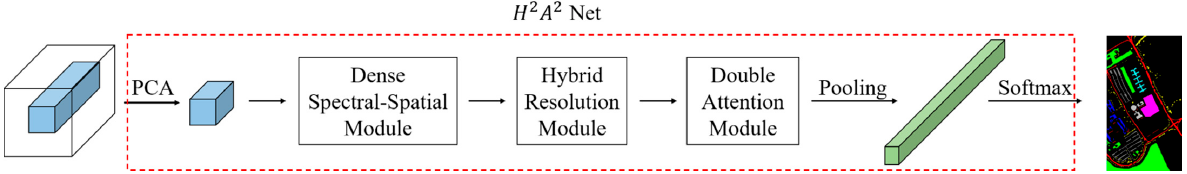
Figure 1. Flowchart of the proposed H 2 A 2 Net.